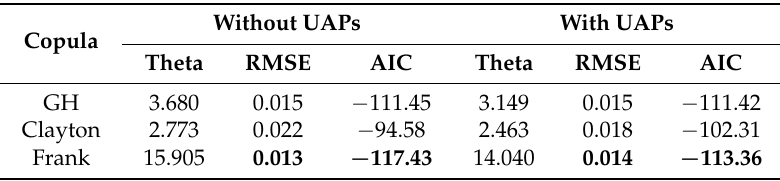
Table 3. The goodness-of-fit test of joint